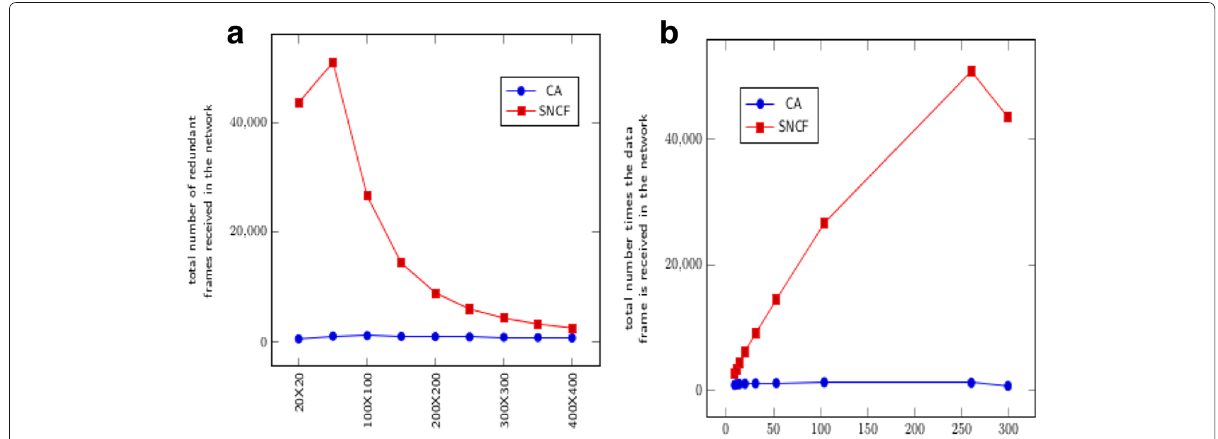
Fig. 21 Redundant frames until the end of events in SNCF and CA protocols. a Against playground size. b Against node density